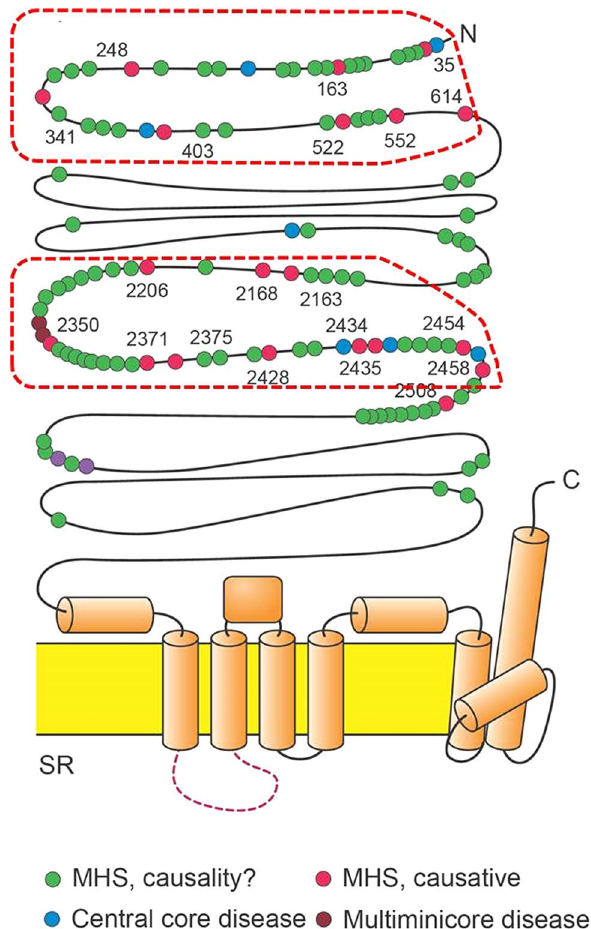
Figure 2. Schematic presentation of the RYR1 gene. Regions with the majority of the pathogenic variants were marked with a red line. Mutations also have been found in the transmembrane domains. In contrast to the mutations in the N-terminal end or in the mid-portion of the receptor, these mutations might only influence the binding of modifying ligands but also directly affect calcium pore flux. Central core disease and multi minicore disease are neuro-muscular disorder which are due to its gene proximity and overlap often associated with malignant